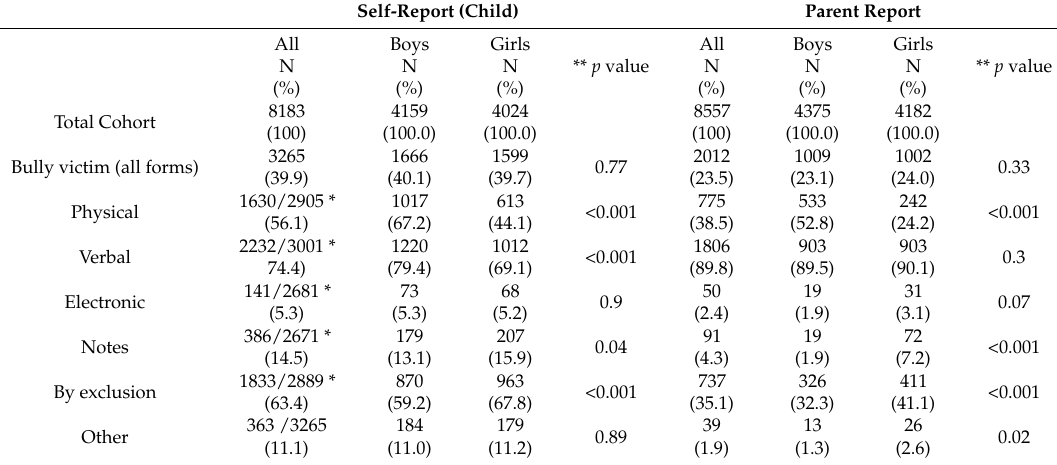
Table 1. Proportion of being vicitimised by bullying and type of bullying in the past year by gender (total cohort N =